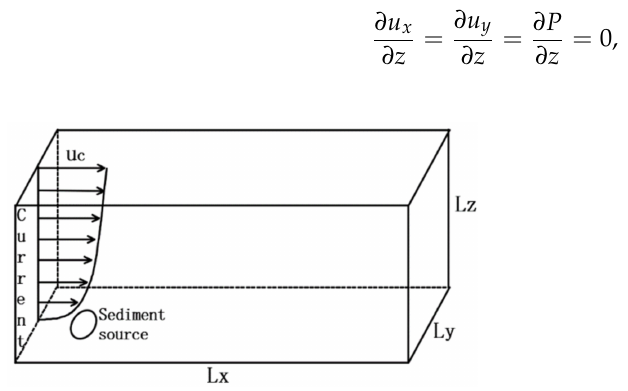
Figure 2. Diagram of the simulation